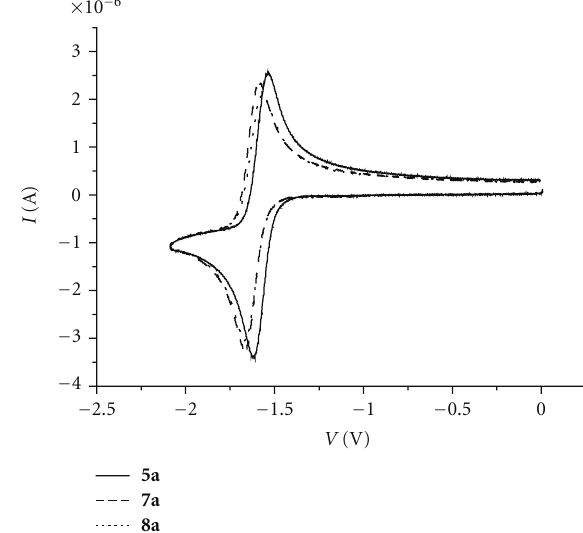
Figure 8: Cyclovoltammograms of monomers 5a – 8a with 1e − transfer (reduction